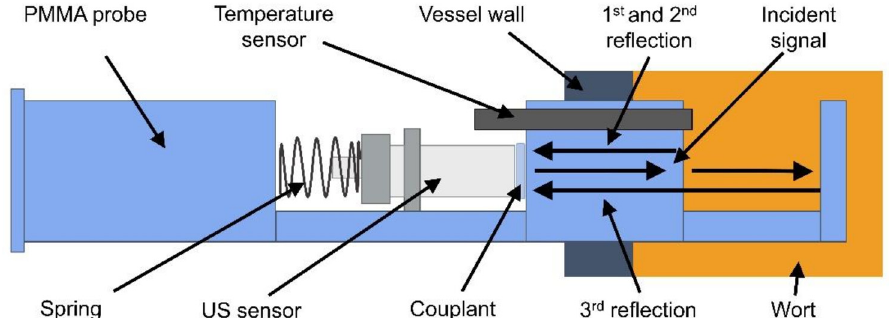
Figure 1. The probe consisting of US and temperature sensors and the paths of the received US sound wave reflections. Adapted from [18].